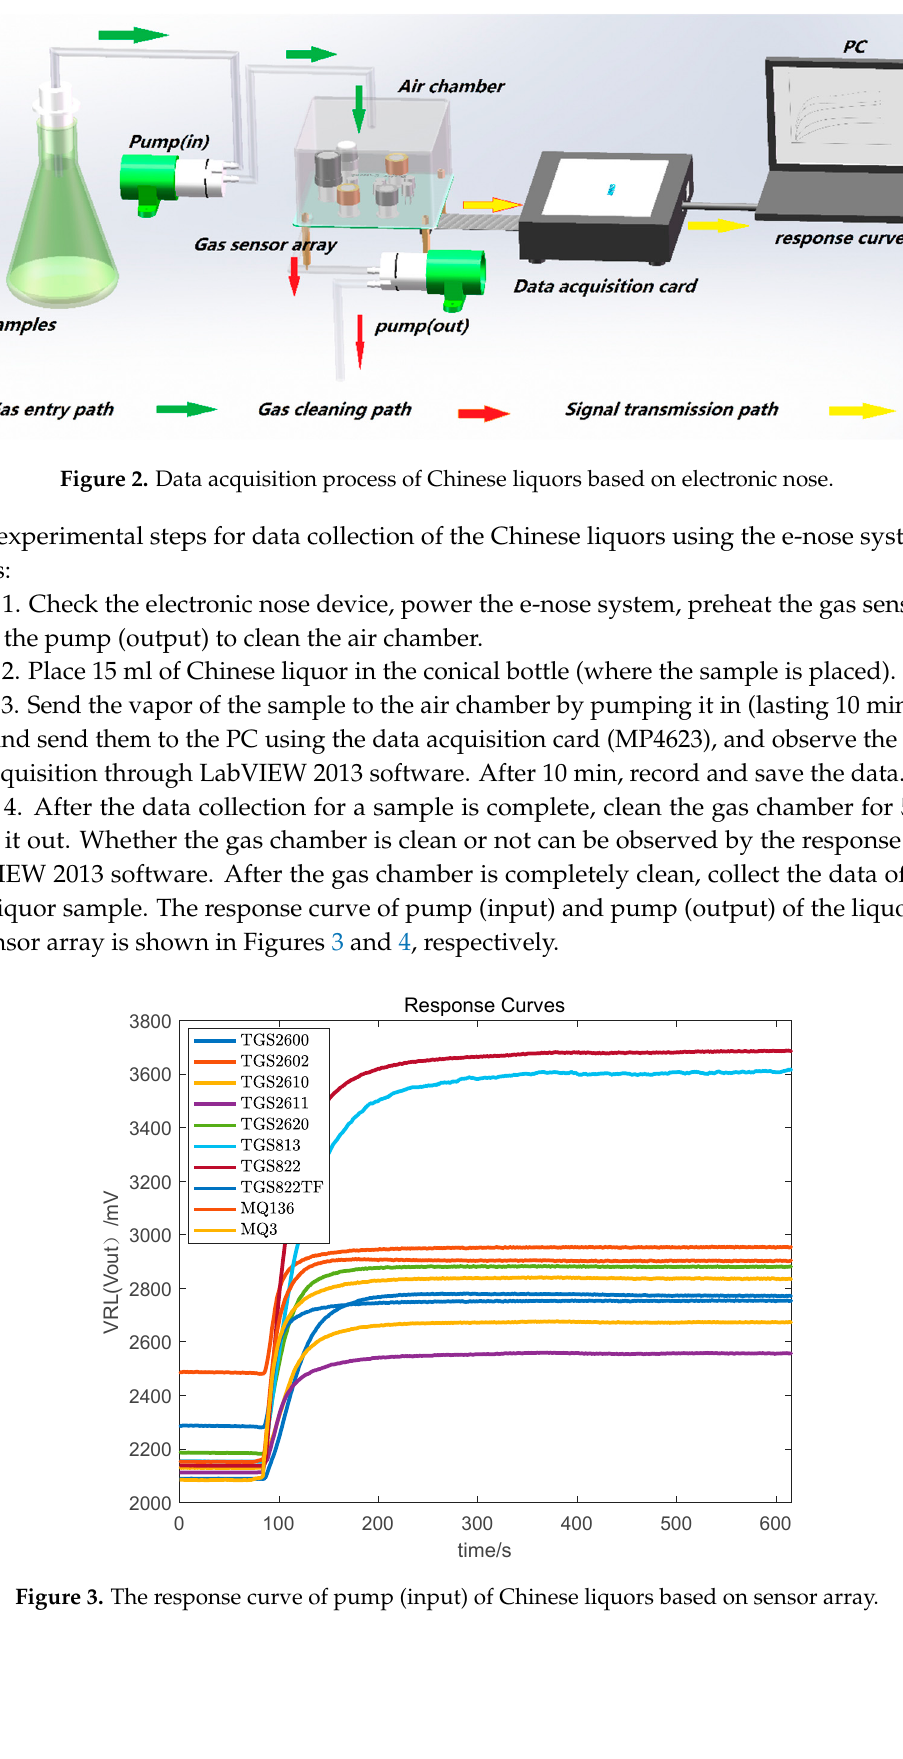
Figure 3. The response curve of pump (input) of Chinese liquors based on sensor array.